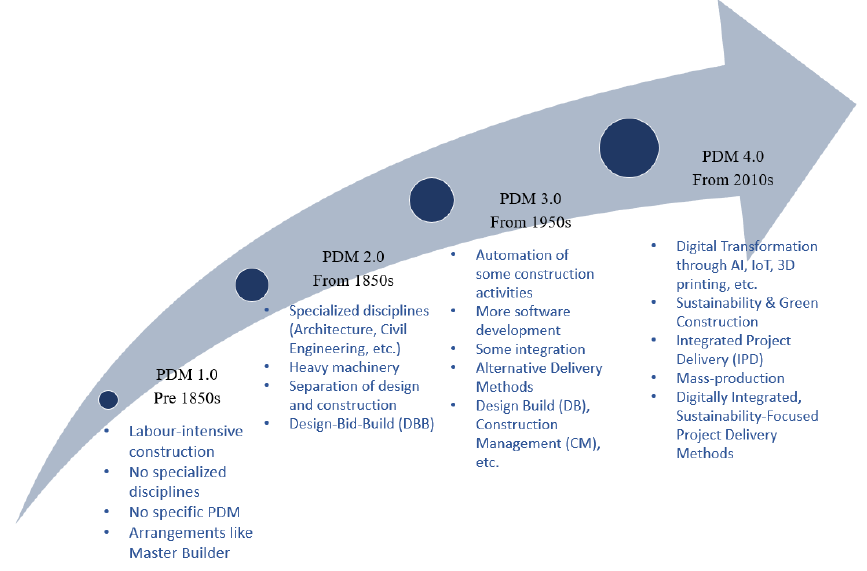
Figure 4. Evolution of project delivery methods.